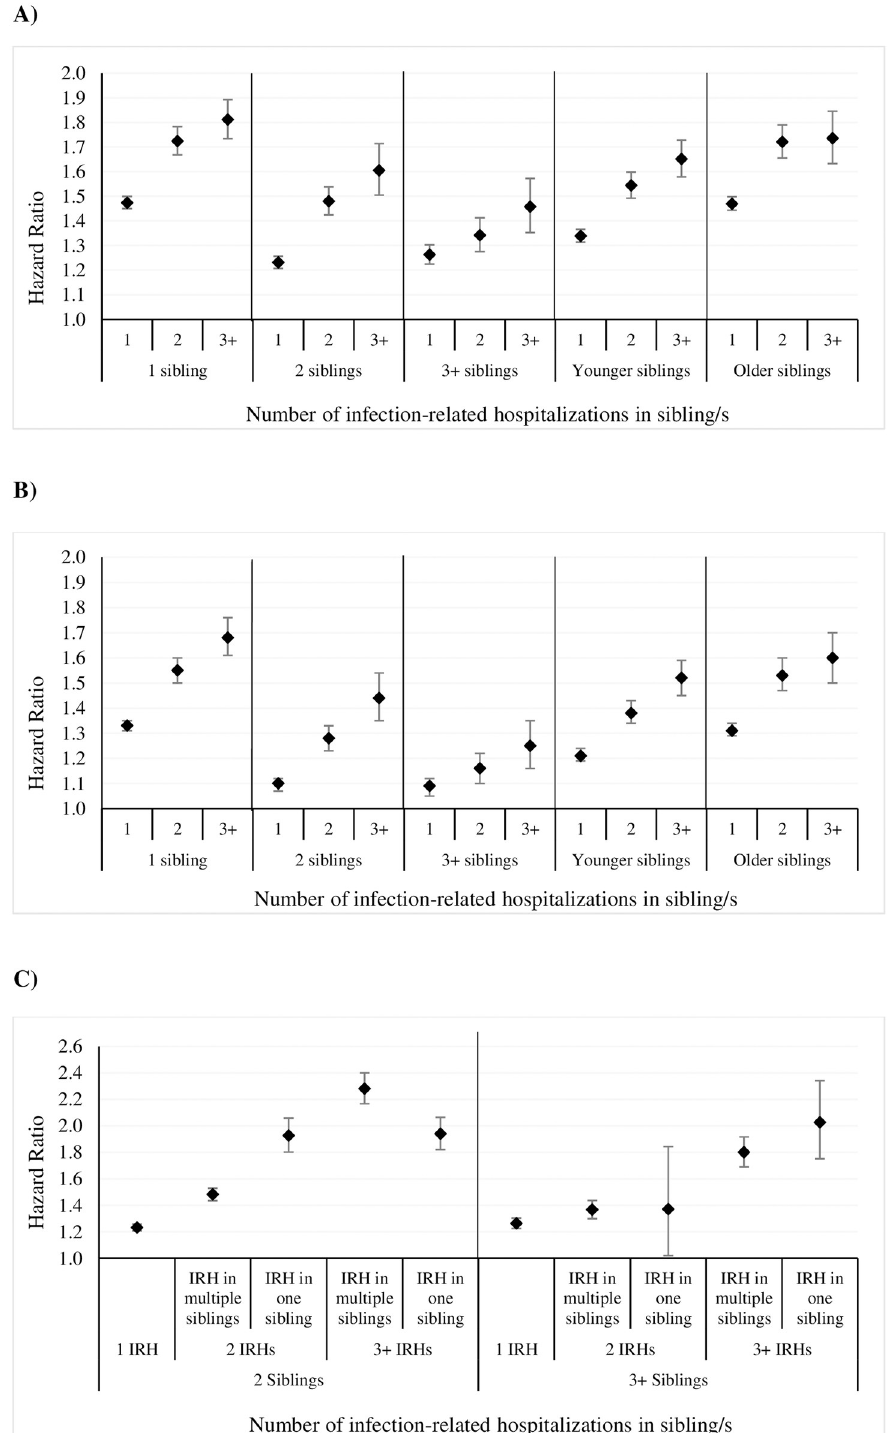
Fig 5. Infection-related hospitalization sibling hazard ratios by family size and sibling characteristics. Adjusted for maternal age, parity, gestational age, birth weight, sex of the child, season of birth, 5-minute Apgar score, birth mode, birth year. (A) Infection-related hospitalization sibling hazard ratios by family size and age of siblings. (B) Infection-related hospitalization sibling hazard ratios excluding proband infection-related hospitalization admissions occurring within 30 days following a sibling infection-related hospitalization exposure. (C) Infection-related